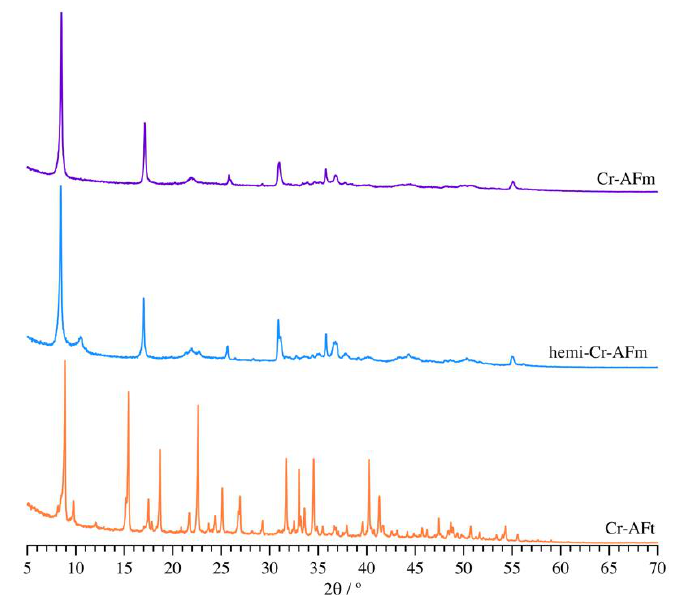
Figure A2. Powder X-ray diffraction patterns for the synthesized monochromate and hemichromate AFm phases and chromate AFt collected on a Rigaku Smartlab diffractometer (CuKa1 radiation).